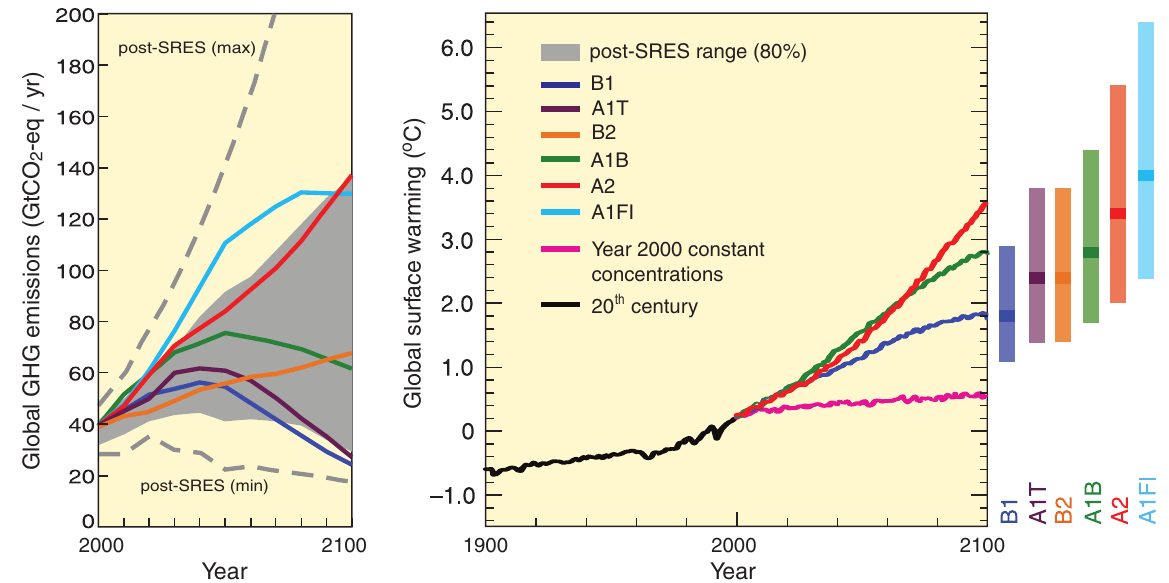
Figure SPM.5. Left Panel: Global GHG emissions (in GtCO -eq) in the absence of climate policies: six illustrative SRES marker scenarios 2 (coloured lines) and the 80 th percentile range of recent scenarios published since SRES (post-SRES) (gray shaded area). Dashed lines show the full range of post-SRES scenarios. The emissions include CO , CH , N O and F-gases. Right Panel: Solid lines are multi-model global averages 2 4 2 of surface warming for scenarios A2, A1B and B1, shown as continuations of the 20 th -century simulations. These projections also take into account emissions of short-lived GHGs and aerosols. The pink line is not a scenario, but is for Atmosphere-Ocean General Circulation Model (AOGCM) simulations where atmospheric concentrations are held constant at year 2000 values. The bars at the right of the figure indicate the best estimate (solid line within each bar) and the likely range assessed for the six SRES marker scenarios at 2090-2099. All temperatures are relative to the period 1980-1999. {Figures 3.1 and